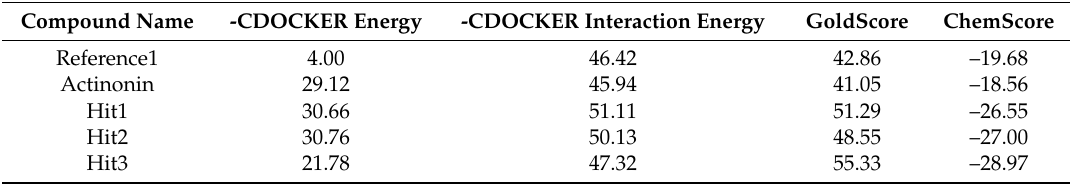
s1, Figure S1: Evaluation of the docking parameters; Figure S2: 2D structures of six compounds; Figure S3: Intermolecular interactions; Figure S4: Pharmacophore models and hits